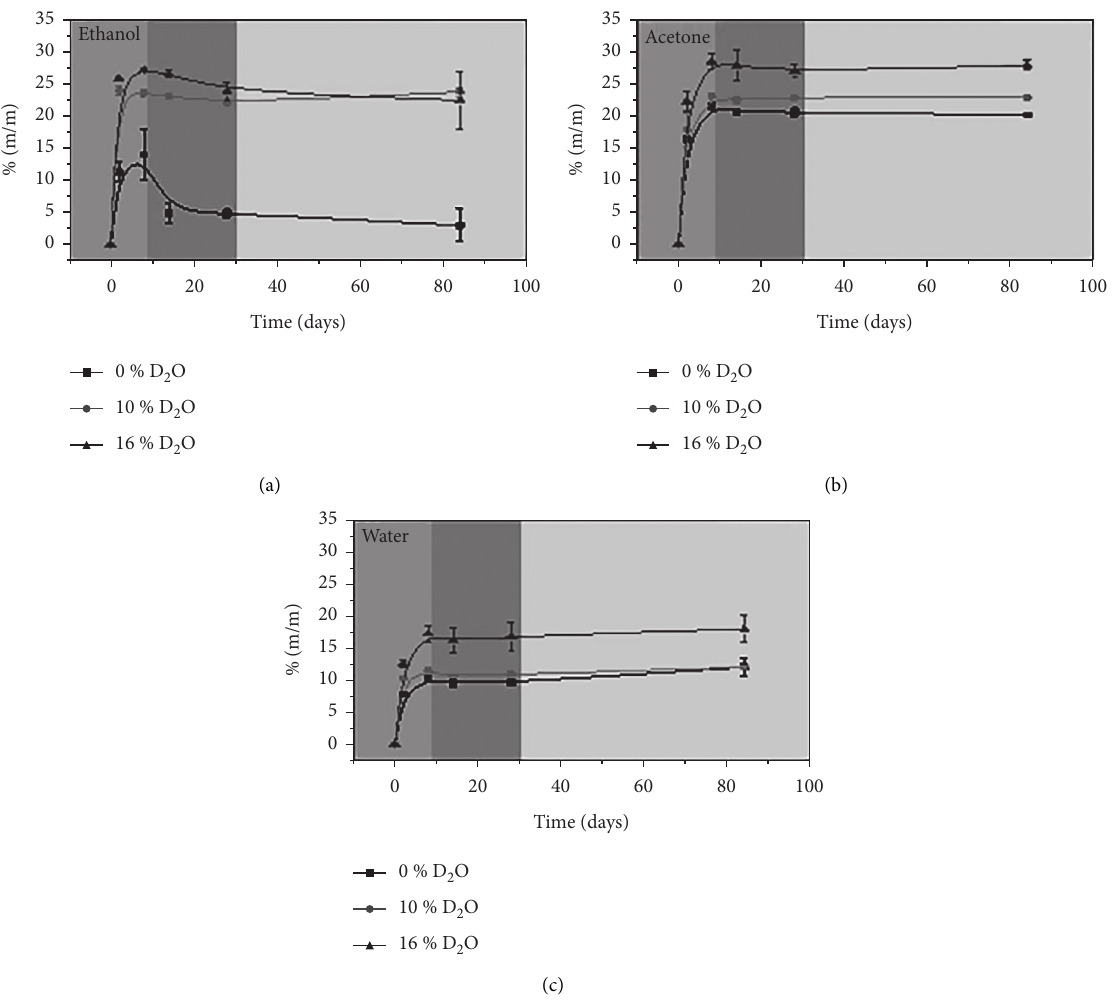
Figure 3: Representative graphs of the sorption of adhesives (%) in relation to the storage